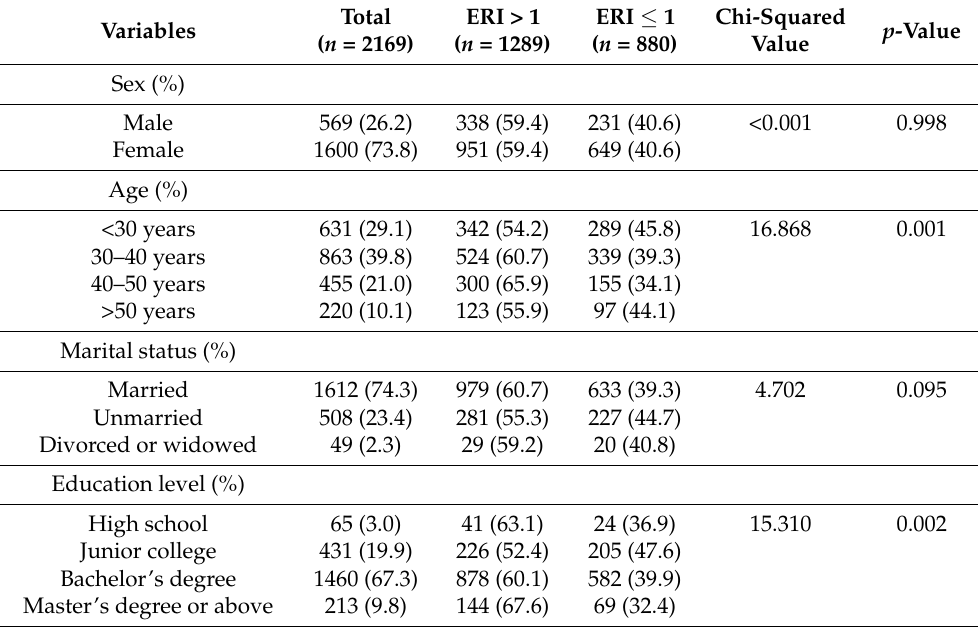
Table 1. Comparison of occupational stress levels in different demographic characteristics. ERI: Effort–Reward Imbalance.